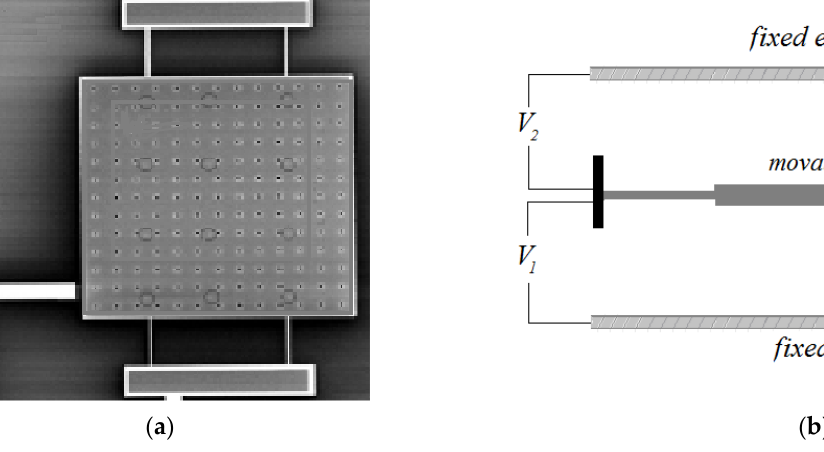
Figure 4. Schematic view of studied microstructure. ( a ) Schematic view of movable electrode from top view [88], ( b ) front view of micro structure.